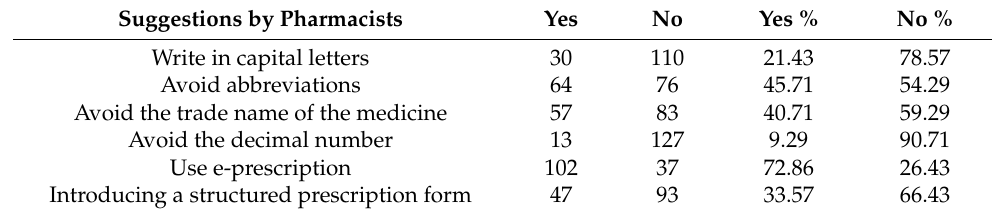
Table 3. Actions suggested by pharmacists to overcome problems due to poor handwriting in prescriptions.